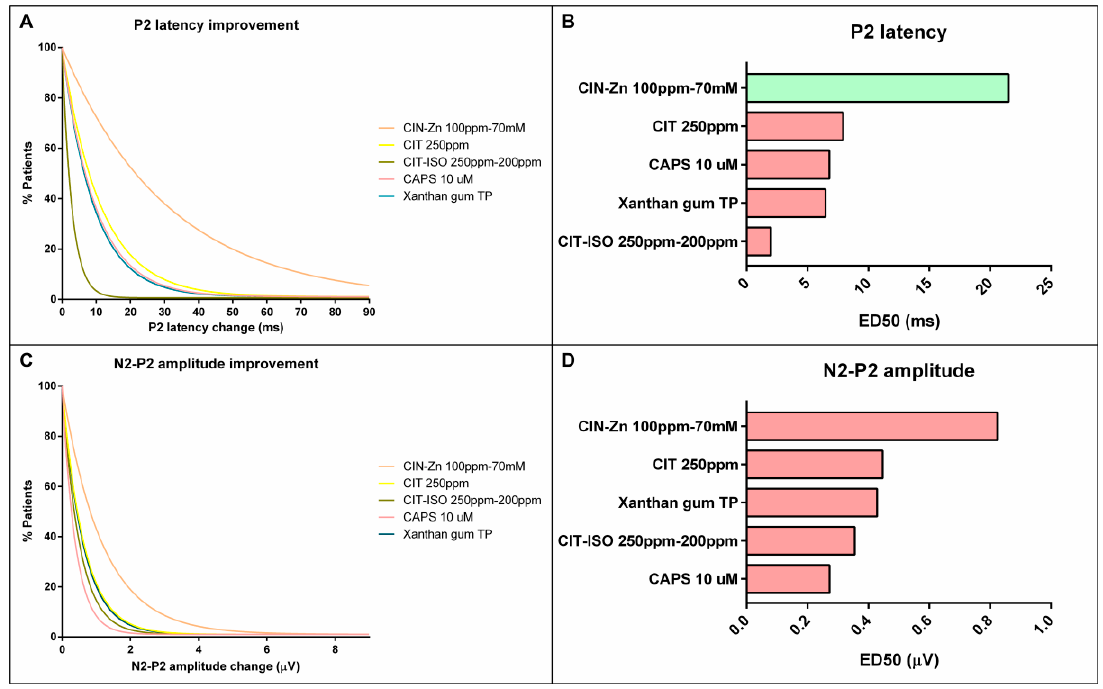
Figure 6. On the left, one-phase decay curves for the proportion of patients with improved P2 peak latency ( A ) and N2-P2 amplitude ( C ). In the right, graphical representation of ED50 for each treatment classified as high (green bars) and low (red bars) therapeutic effects for P2 peak latency ( B ) and N2-P2 amplitude ( D ). CAPS: capsaicin; CIN-Zn: cinnamaldehyde-zinc; CIT: citral; CIT-ISO: citral-isopulegol; TP: thickening product. Table 3. Parameters of the one-phase decay curves for the proportion of patients with improved P2 peak latency and N2-P2 amplitude.